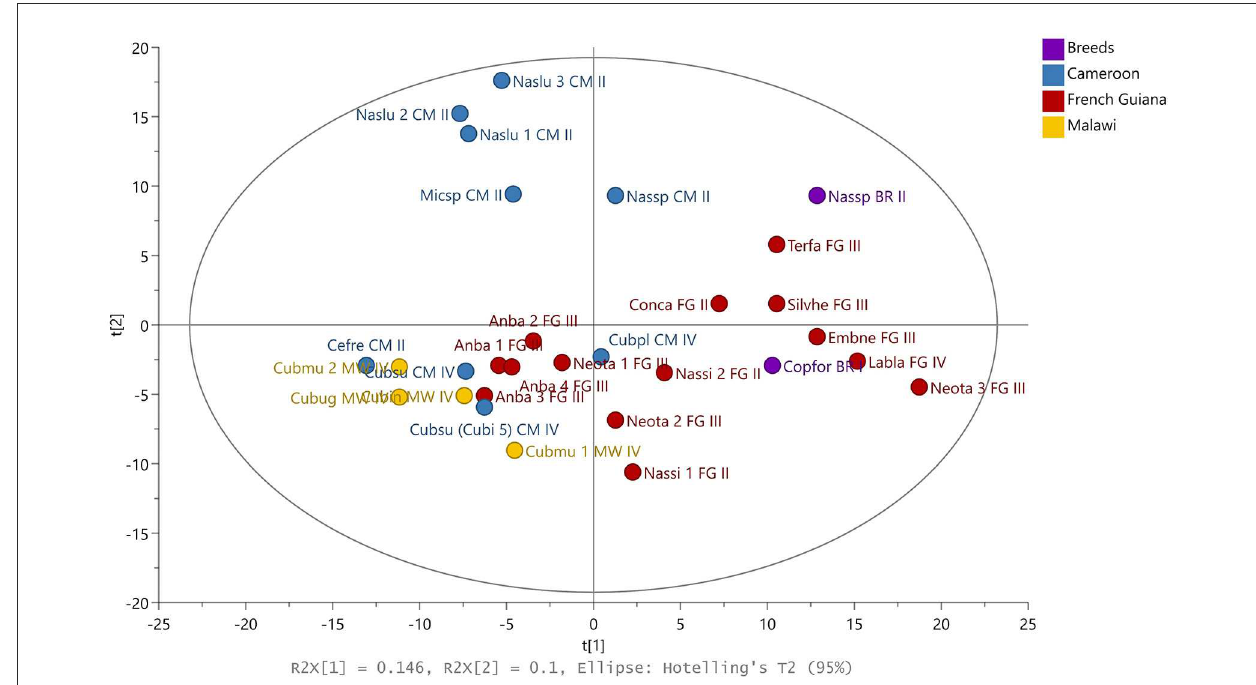
FIGURE1 PCA scores plot using SPME-GC-TOF-MS data from the non-targeted analysis. Samples are colored according to geographical location: violet, Breeds; blue, Cameroon; red, French Guiana; yellow, Malawi. Anba, Anoplotermes banksi ; Cefre, Cephalotermes rectangularis ; Conca, Constrictotermes cavifrons ; Copfor, Coptotermes formosanus ; Cubug, Cubitermes aff. ugandensis ; Cubin, Cubitermes inclitus ; Cubmu, Cubitermes muneris ; Cubpl, Cubitermes planifrons ; Cubsu, Cubitermes sulcifrons ; Embne, Embiratermes neotenicus ; Labla, Labiotermes labralis ; Micsp, Microcerotermes sp.; Naslu, Nasutitermes lujae ; Nassi, Nasutitermes similis ; Nassp , Nasutitermes sp.; Neota, Neocapritermes taracua ; Silvhe, Silvestritermes heyeri ; Terfa, Termes fatalis ; CM, Cameroon; FG, French Guiana; MW, Malawi; I, Feeding Group I; II, Feeding Group II; III, Feeding Group III; IV, Feeding Group